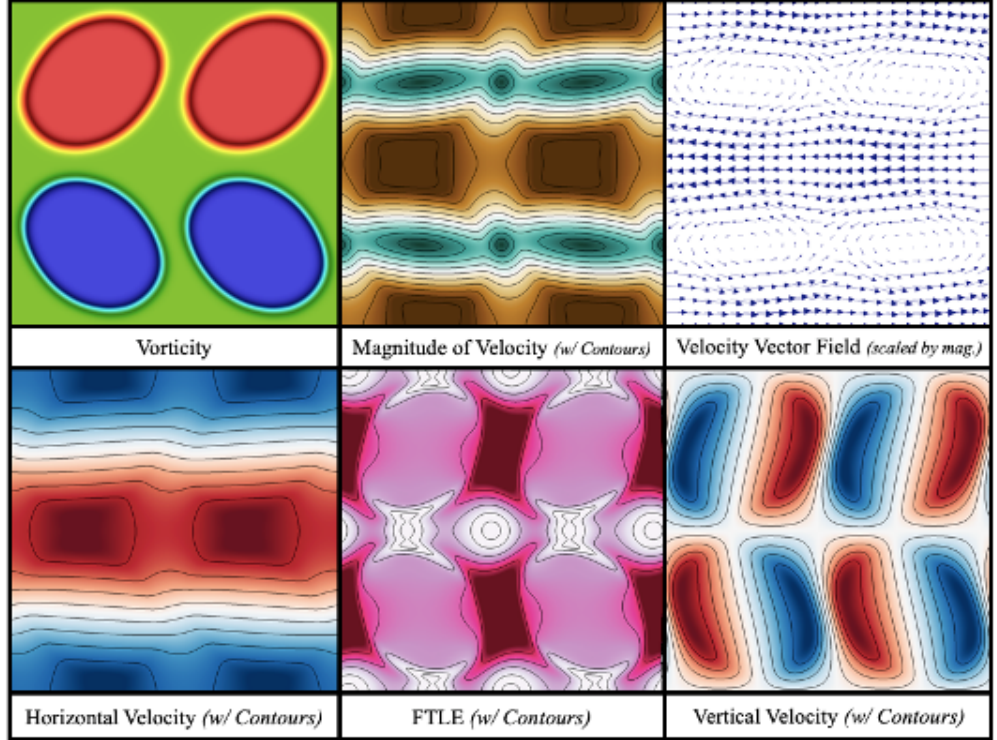
Figure 29. Illustrations of the simulation data produced during the case of 4 interacting vorticity regions. The data shown is from the last